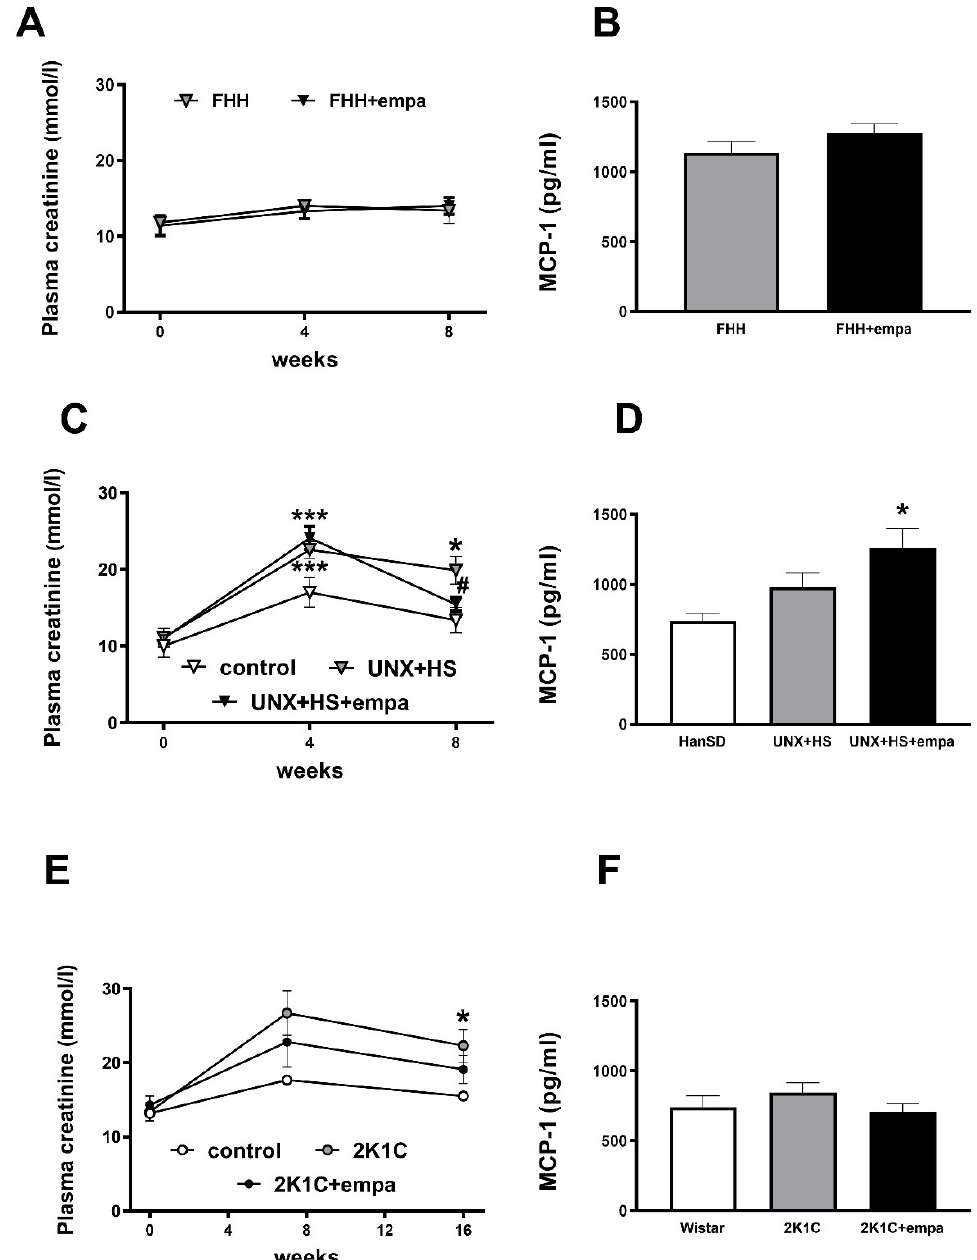
Figure 5. The effect of empagliflozin treatment on plasma creatinine ( A , C , E ) and on plasma monocyte attractant protein-1 (MCP-1) ( B , D , F ) in fawn-hooded hypertensive rats ( A , B ), uninephrectomized (UNX) Hannover Sprague Dawley (HanSD rats on high-salt (HS) diet ( C , D ), and Wistar rats subjected to renal artery stenosis (Goldblatt 2K1C hypertension) ( E , F ). * p < 0.05 vs. control group, # p < 0.05 vs. untreated group. * denotes p < 0.05 and *** denotes p < 0.001; data are means ± SEM.